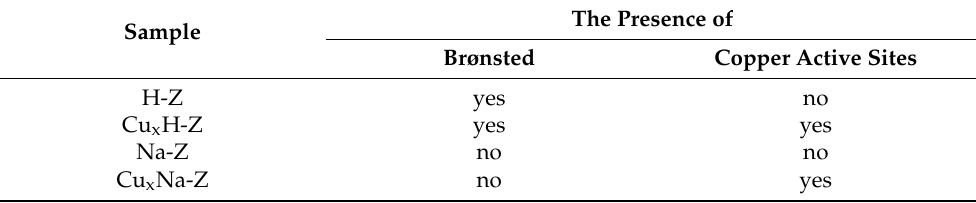
Table 6. The occurrence of different active center types in dependence on the preparation of the sample. The Presence of Sample Brønsted Copper Active